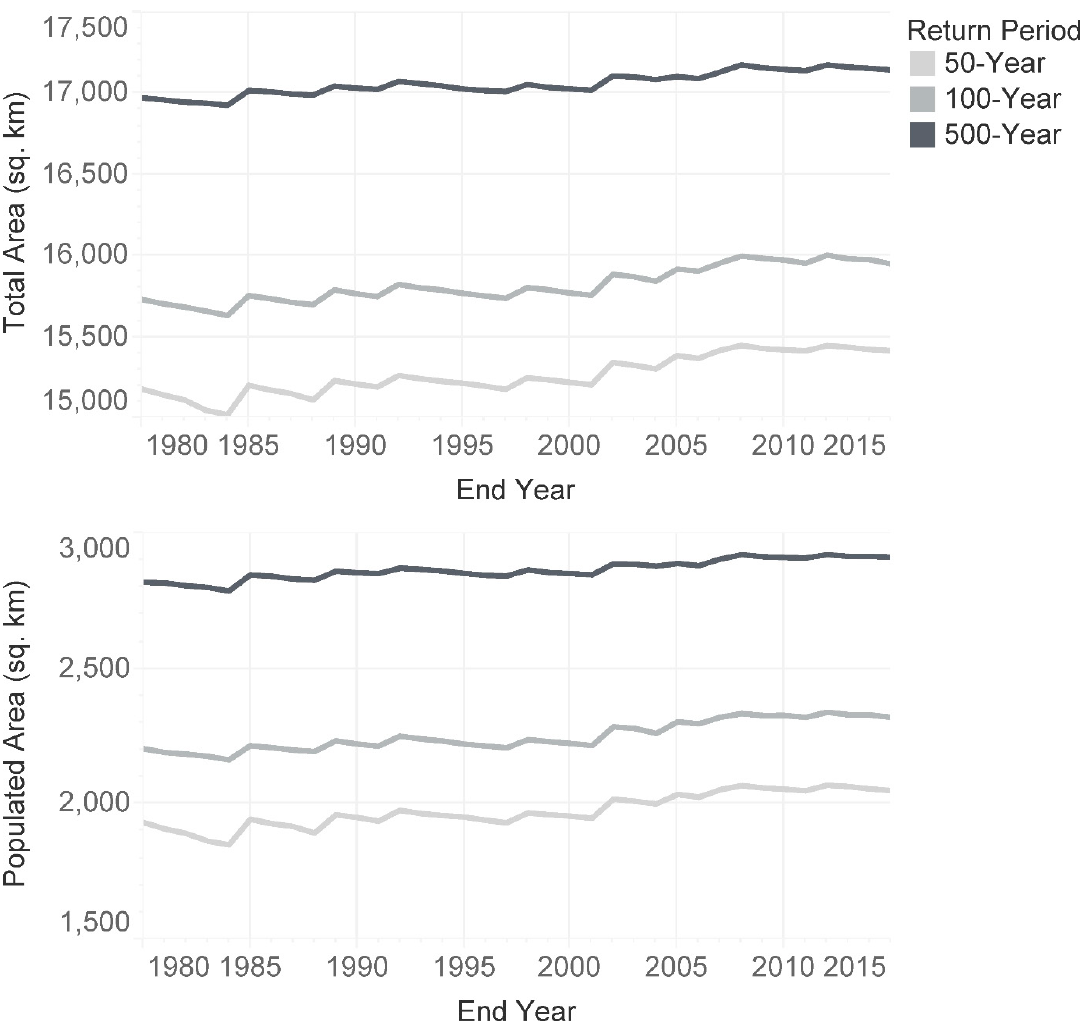
Figure 6. Floodplain extent by year, total land area ( top ) and populated area ( bottom